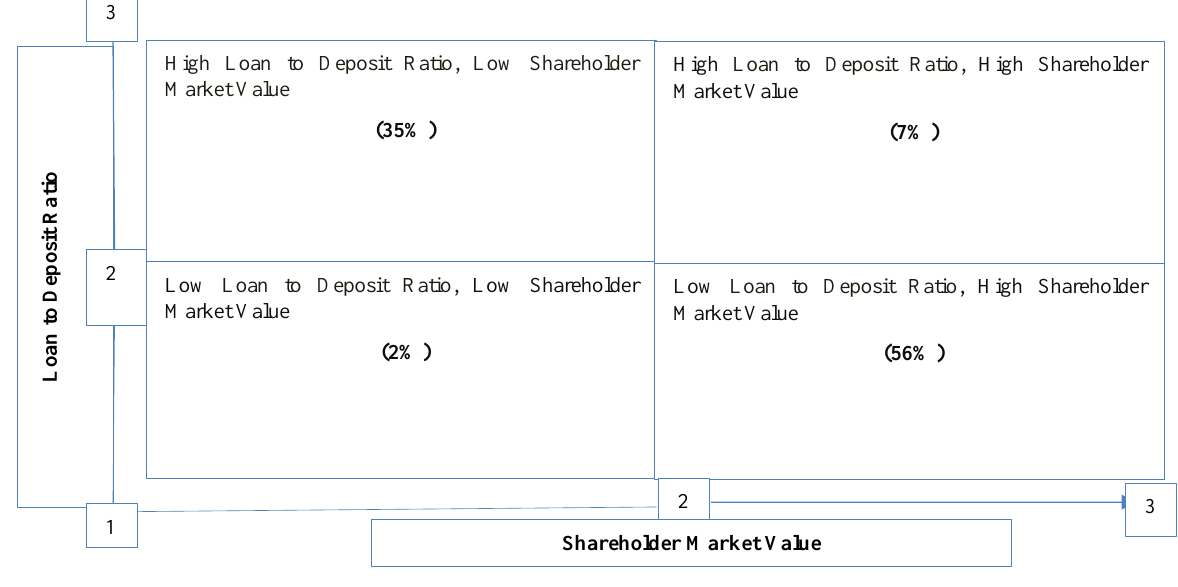
Figure 5: Typology of loan to deposit ratio and shareholder market